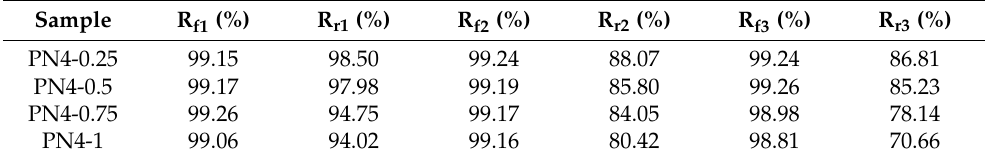
Table 6. R fn and R rn of the PLA/PCL nanocomposites with different CNC-OMMT contents.